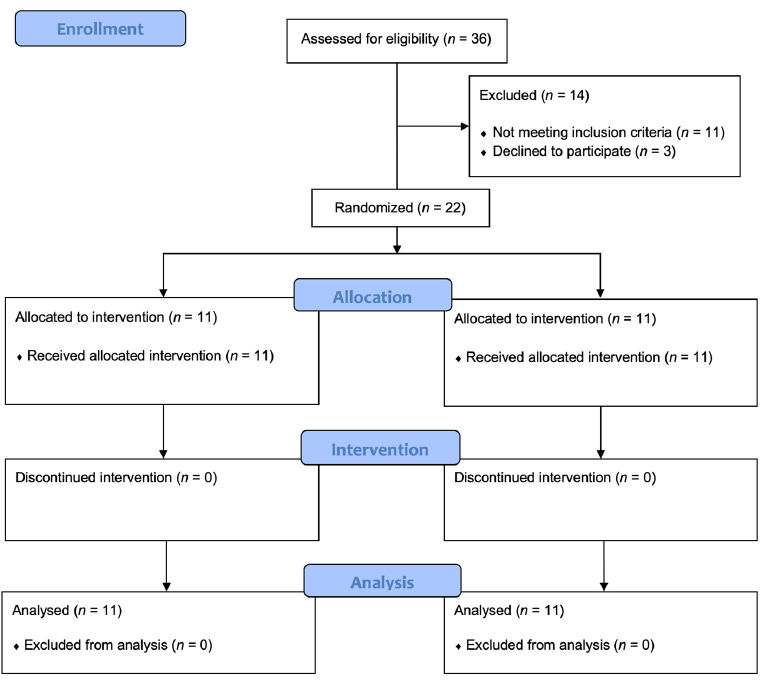
Figure 3. Study flow-chart. There were no statistically significant differences between the groups in terms of age, BMI, breast surgery, axillary surgery, radiotherapy, or upper limb lymphedema. Baseline characteristics of patients are reported in Table